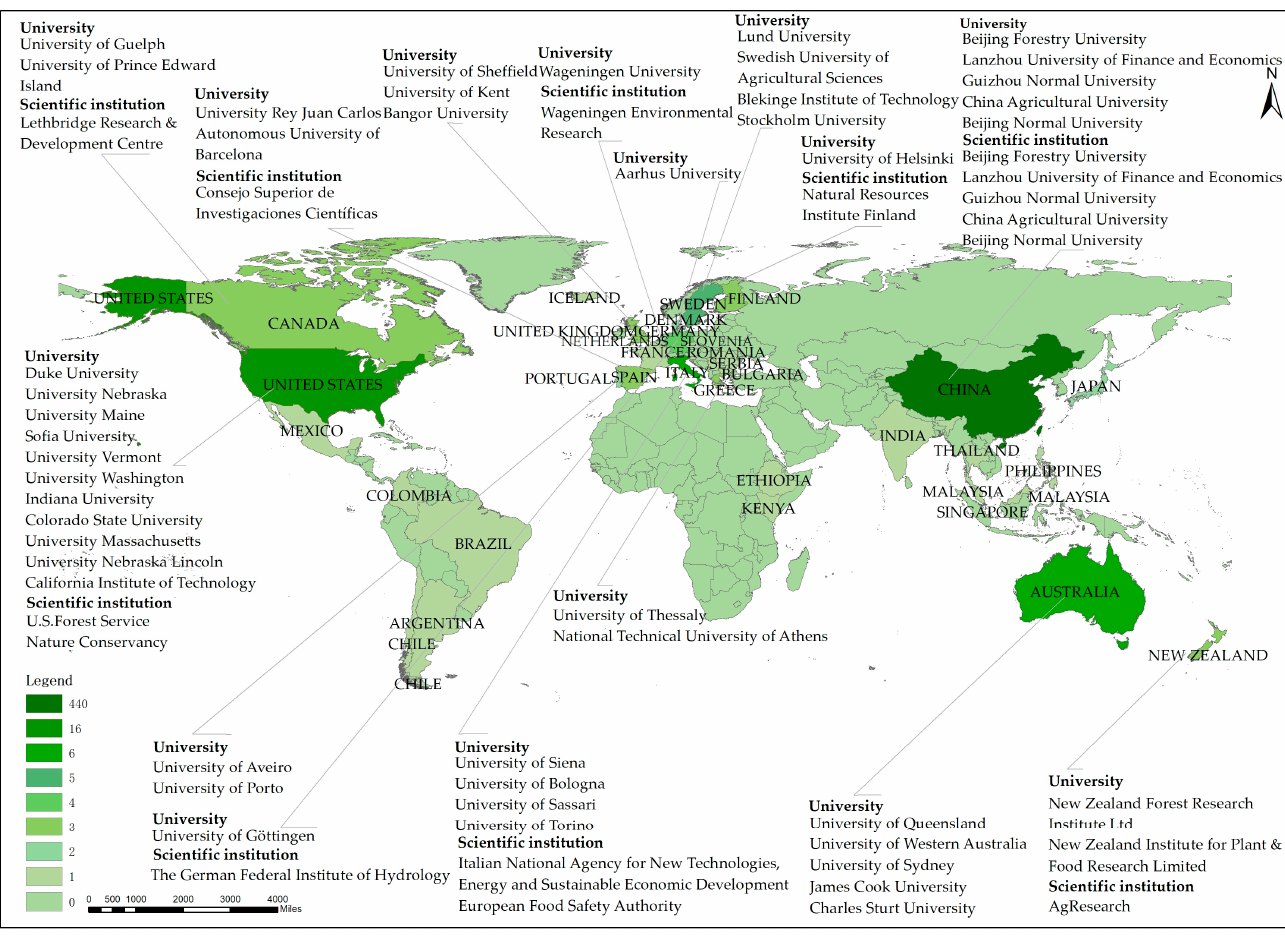
Figure 4. The breakdown of the institutions and nations described in the study (due to space limitations, only countries with more than two publications are marked). The number of publications is indicated by the bottom digits and bands of different colors; the greener the color, the more publications are cited.